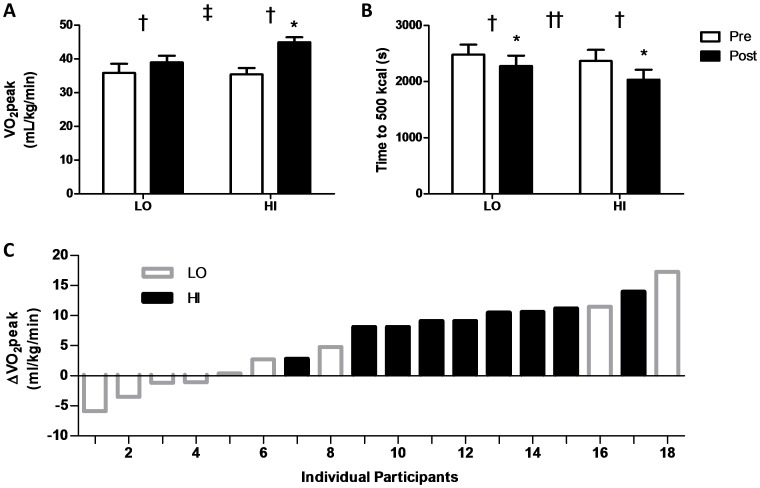
Improvements in VO2peak and exercise performance are greater following HI than LO.The mean VO2peak (A) and time to 500 kcal (B) for the LO and HI groups are shown. The individual change in VO2peak for all participants are also shown (C). *Significant (p<0.05) difference from Pre. † Significant (p<0.05) effect of training. ‡ Significant (p<0.05) interaction. ††Non-significant (p = 0.07) interaction.